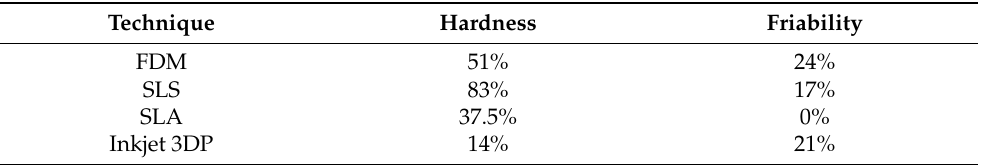
Table 8. Schematic summaries of the two characterization tests (hardness; friability) performed with the four 3DP techniques (FDM; SLS, SLA; inkjet 3DP) and quantification in how many articles were evaluated